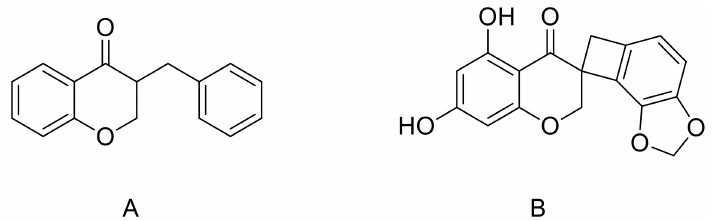
Figure 2. Structures of 3-benzylchroman-4-one ( A ) and scillascillin ( B